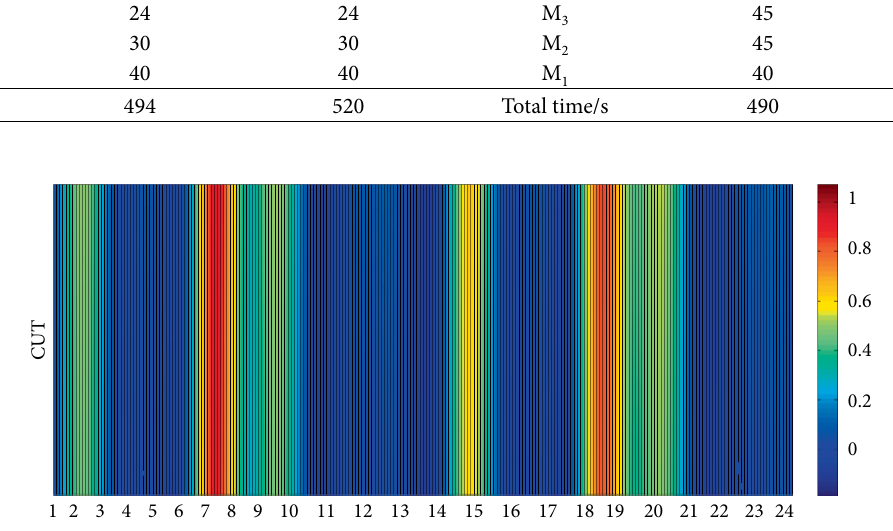
Figure 10: The regenerative braking energy utilization ratio in each section of the CUT.